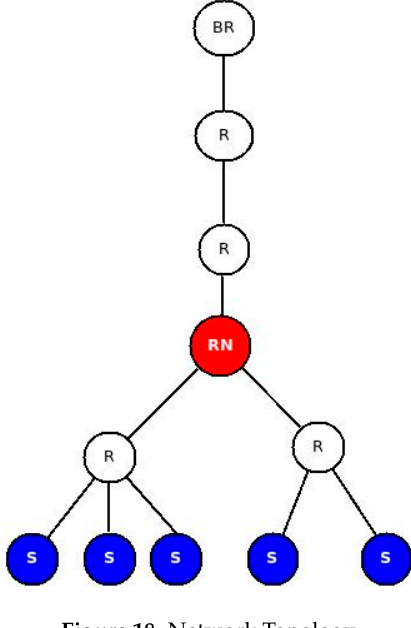
Figure 18. Network Topology.